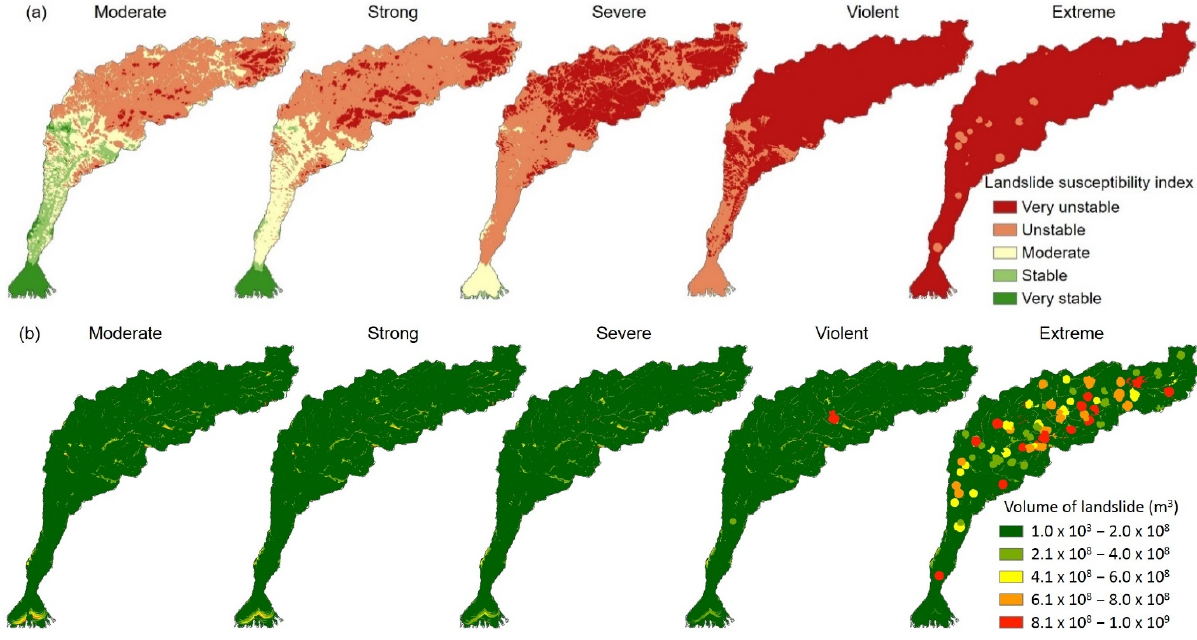
Figure 3. Maps of ( a ) landslide susceptibility index and ( b ) volume of landslide under five earthquake scenarios in the Mailuu-Suu catchment.